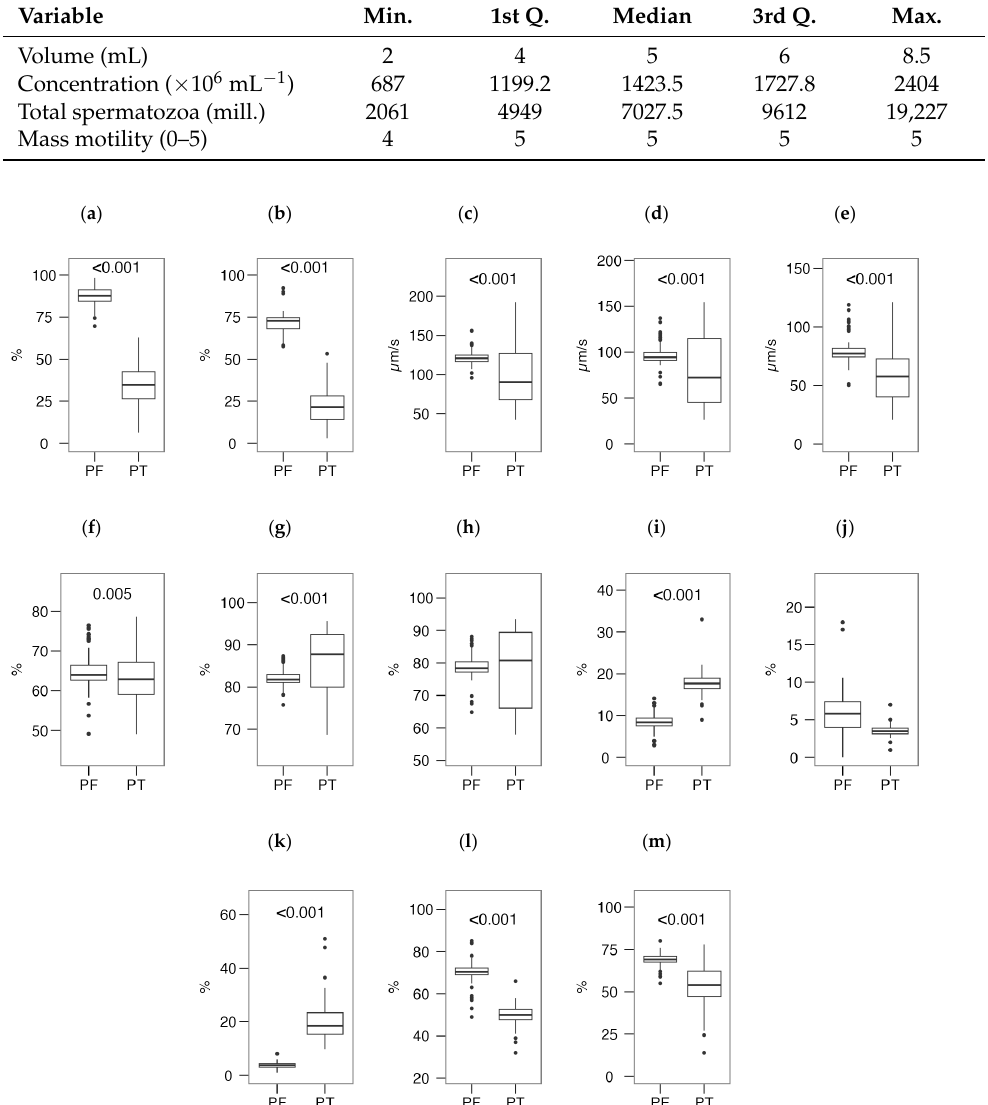
Table 1. Descriptive statistics for the routine evaluation of the ejaculates in the AI center (40 Asturiana de la Montaña bulls, 102 ejaculates).